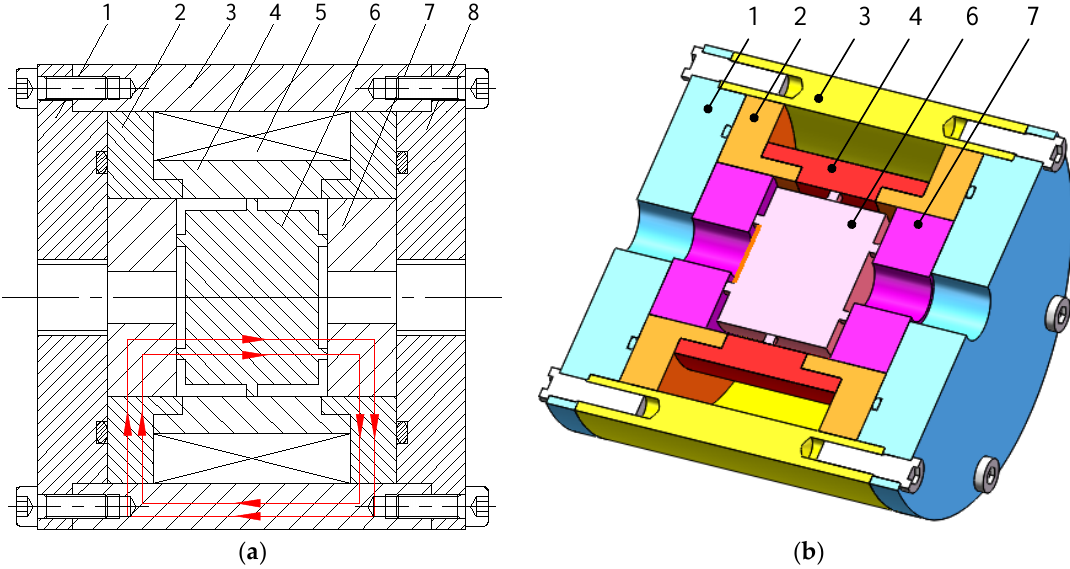
Figure 1. Structure diagram of radial MR valve with single excitation coil. ( a ) Schematic diagram; ( b ) 3D diagram. 1-Left end cover; 2-Magnetic disk; 3-Valve body; 4-Nonmagnetic sleeve; 5-Excitation coil; 6-Valve spool; 7-Positioning plate; 8-Right end cover.